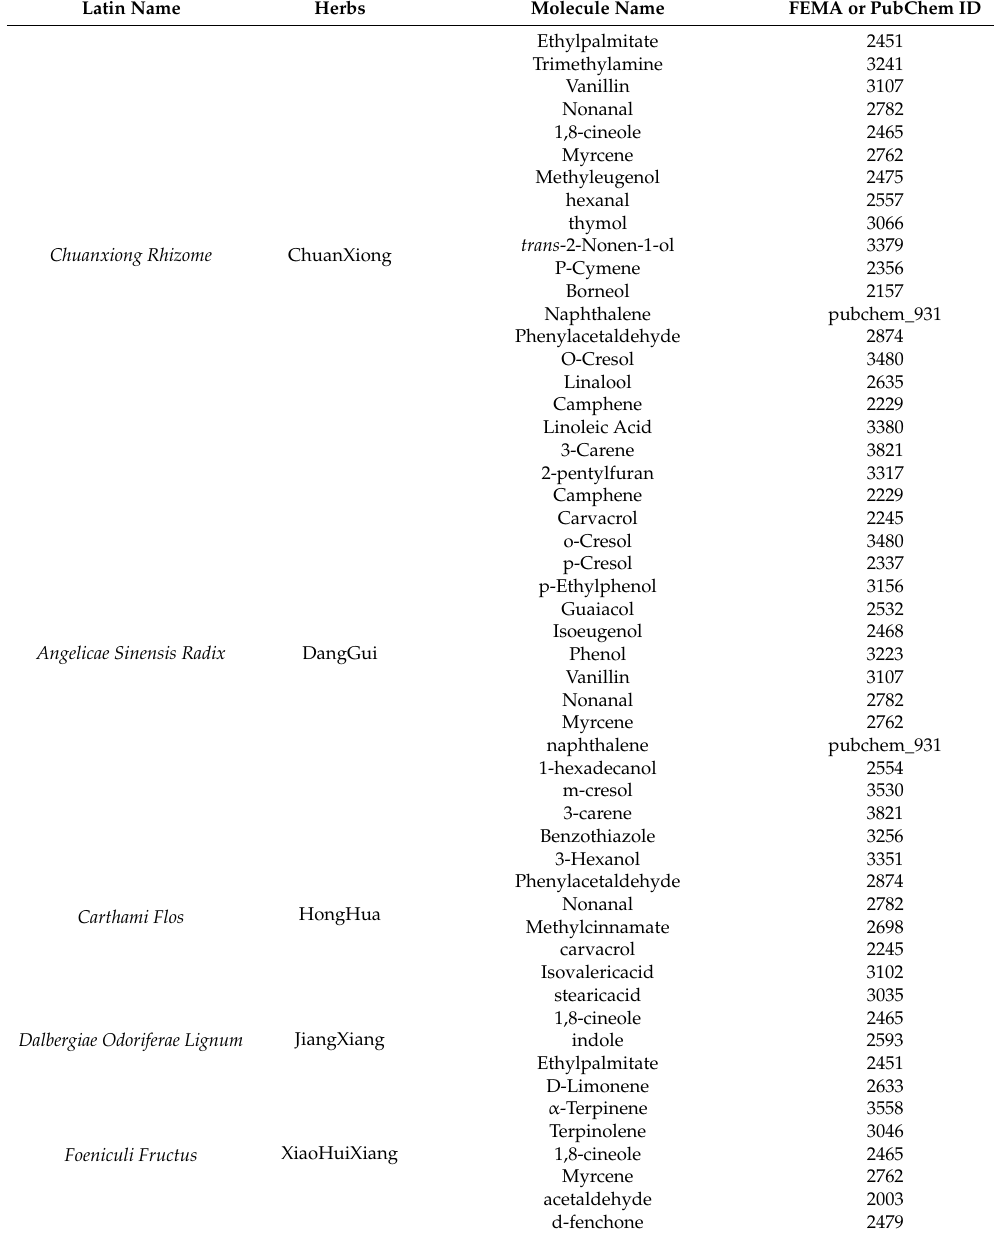
Table 3. Pungent flavored compounds from pungent